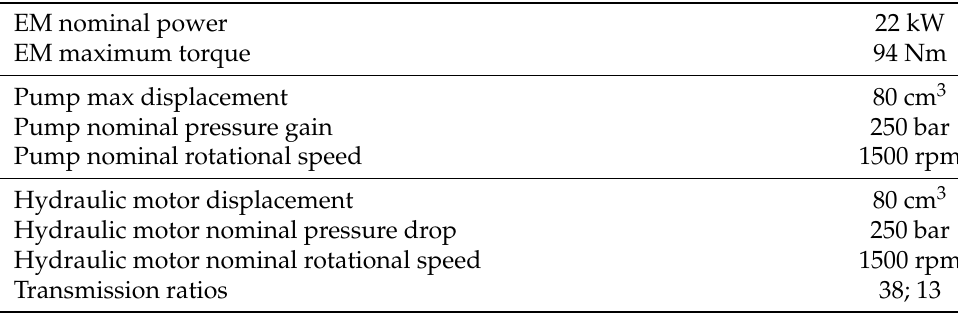
Figure 10. Schematic representation of the electro-hydraulic architecture. Table 6. Main properties of the electro-hydraulic